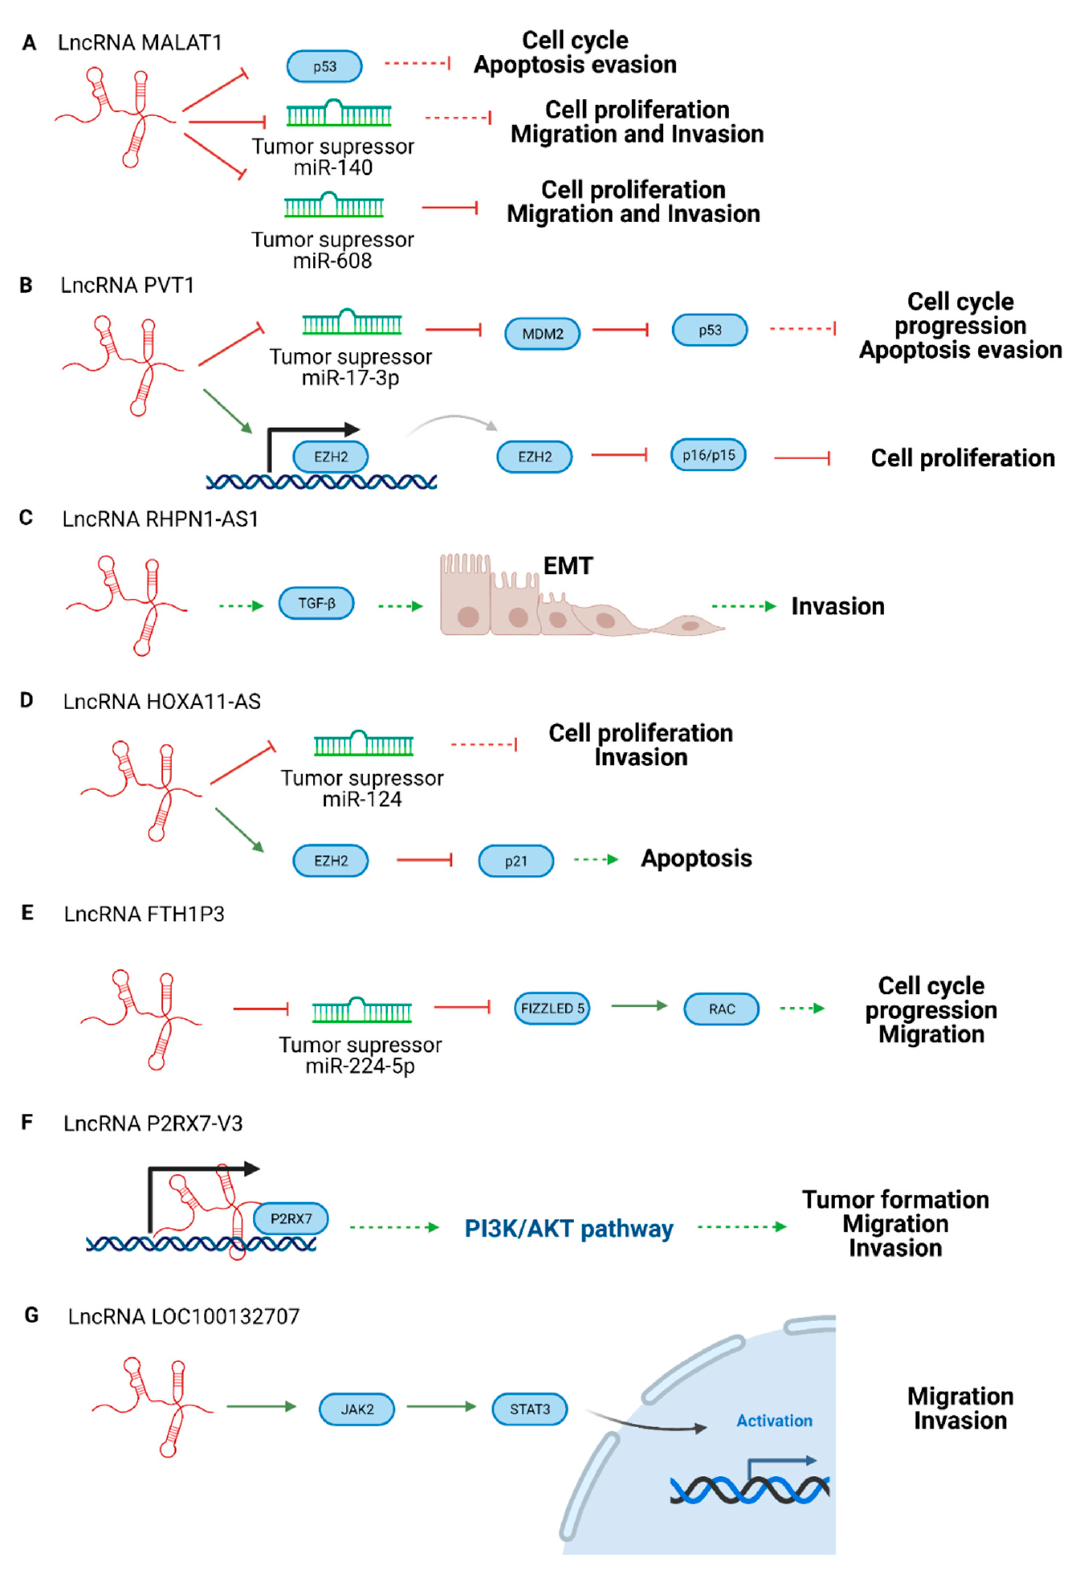
Figure 3. Scheme of oncogenic lncRNA pathways in UM. ( A ) LncRNA MALAT1, ( B ) lncRNA PVT, ( C ) lncRNA RHPN1-AS1, ( D ) lncRNA HOXA11-AS, ( E ) lncRNA FTH1P3, ( F ) LncRNA P2RX7-V3, and ( G ) LncRNA LOC100132707. Created with